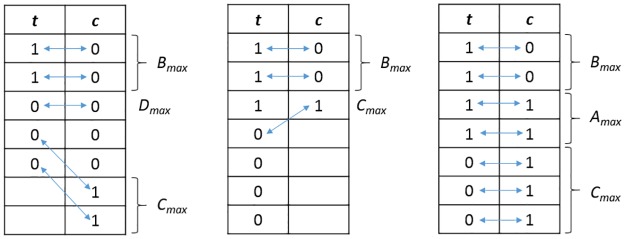
Example of maximum pair assignments between treatment and control group.t represents the treatment group and c represents the control group. An arrow connects a treatment unit with a control unit which forms a pair.